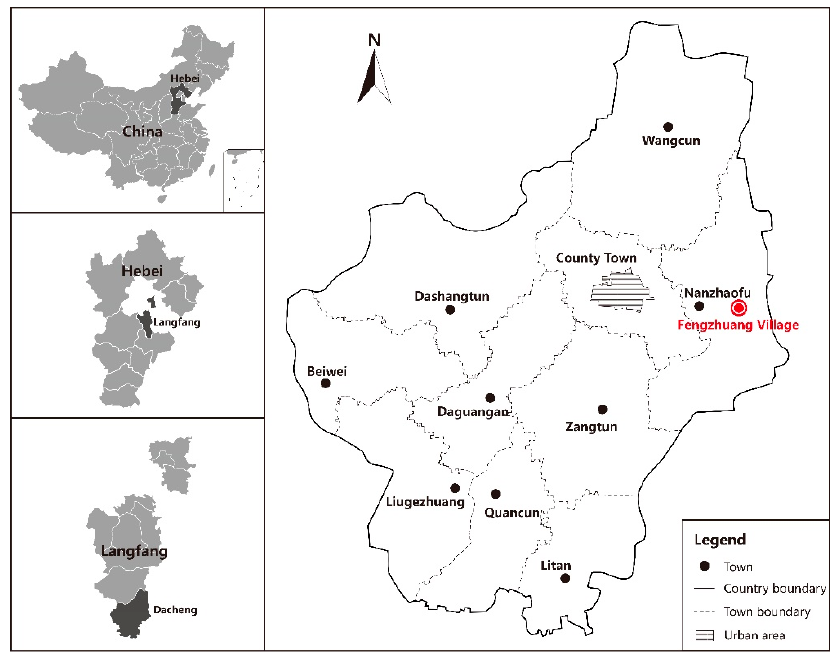
Figure 1. Location of Fengzhuang, Hebei, China.